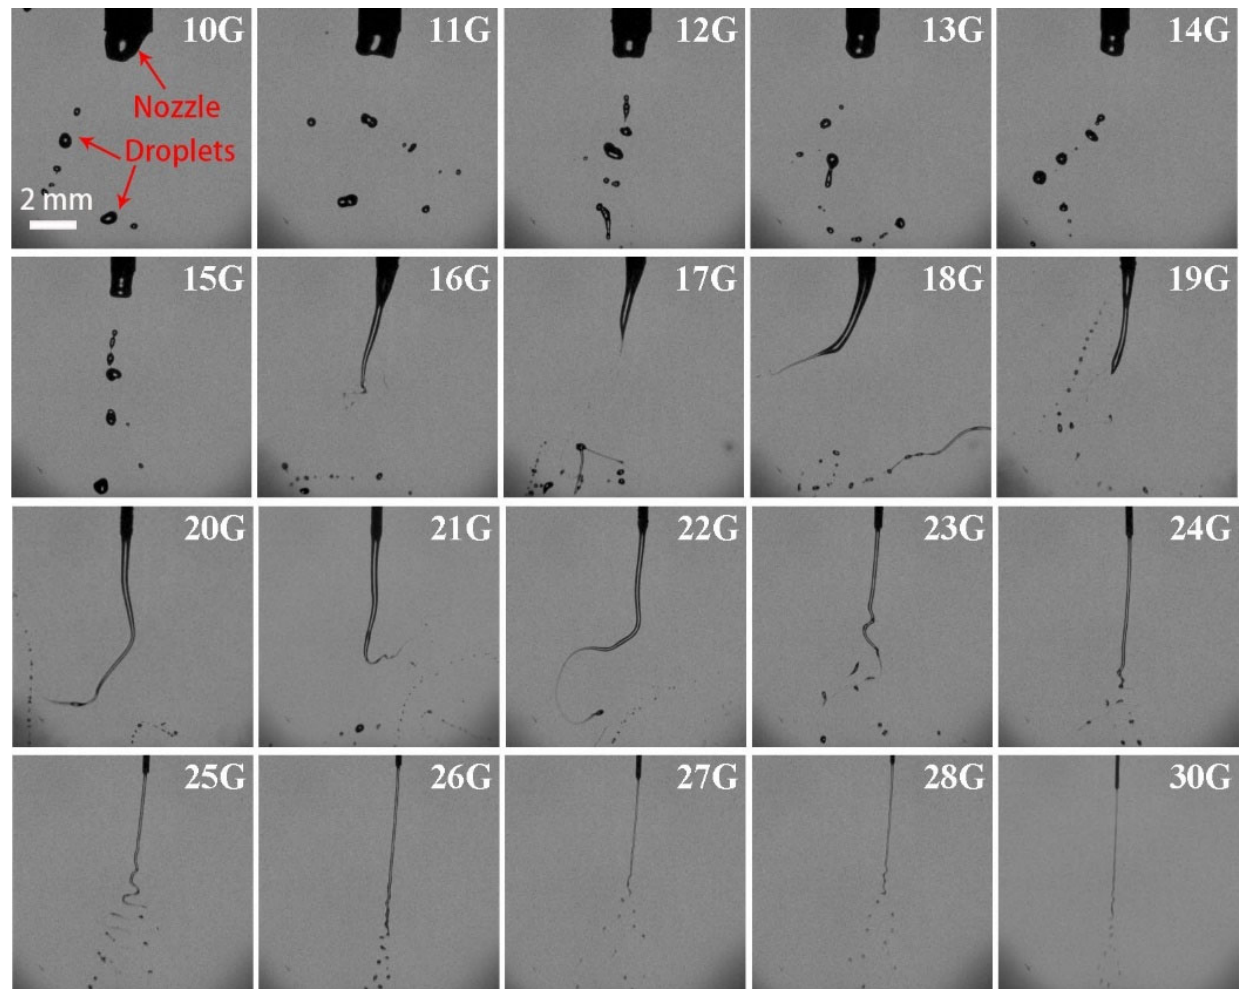
Figure 9. Pictures of electrostatic breakup of H 2 O 2 ligaments and droplet formation at different nozzle sizes (flow rate of 500 mL/h, voltage of 28 kV, 35 wt. % concentration). The average diameters of breakup droplets totally showed a nonmonotonic downward trend with decreasing the nozzle size, but there were two significant leaps at 13G–15G and at 22G–23G, respectively. For 23G–30G (inner diameter 160–330 µ m), the atomization cone angle increased. The droplet-size distribution of 23G was wider than 22G. To obtain opti- mum breakup performance, in this case, 20G–22G nozzles (inner diameter of 0.4–0.6 mm) need to be installed. The average diameters of droplets reached the minimum value of 90.7 µ m with good uniformity and dispersion at